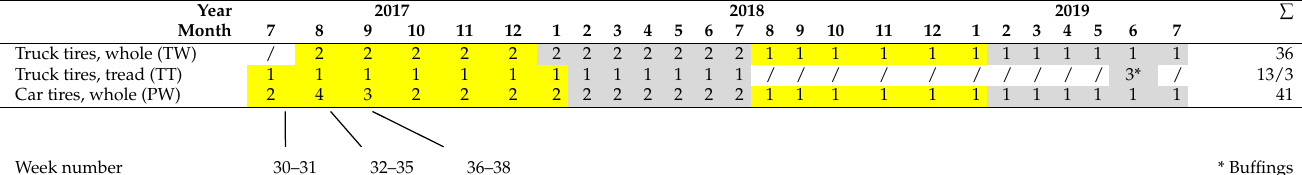
Table 2. Measurement frequency of the different